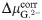
Compiled results from experiment and FEM simulations.(A)The concentration of Gd(DTPA)2− in the polyelectrolyte solution at a position 4 mm from the membrane for two samples with FCD = -108 mM: one with small effects due to convection (circles) and one with noticeable convection at the beginning of the experiment (triangles), as a function of time. The solid lines are the corresponding values from FEM simulations with fitted values of ΔμG.2−corr and the dashed line represents the corresponding results from a simulation with Δμicorr=0 for all ions. (B) Experimental (dashed) and simulated (solid) values for the concentration of Gd(DTPA)2− at different positions along the container, z, for a polyelectrolyte solution with FCD = -108 mM. (C) Simulated values for the concentration of Gd(DTPA)2− at different positions along the container, z, for a polyelectrolyte solution with FCD = -108 mM. The dashed line shows the result from a FEM simulation with fitted value of ΔμG.2−corr and the solid line represents the corresponding results from a simulation with Δμicorr=0 for all ions. (D) The step in concentration at z = 0, ΔcG.2−=Cp(0−)G.2−−Cs(0+)G.2− (see also Fig 4), at different times for three polyelectrolyte solutions with different FCD. The dashed lines correspond to the individual experiments and the solid lines represent the corresponding mean value of the duplicate experiments. The data are taken from FEM simulations.